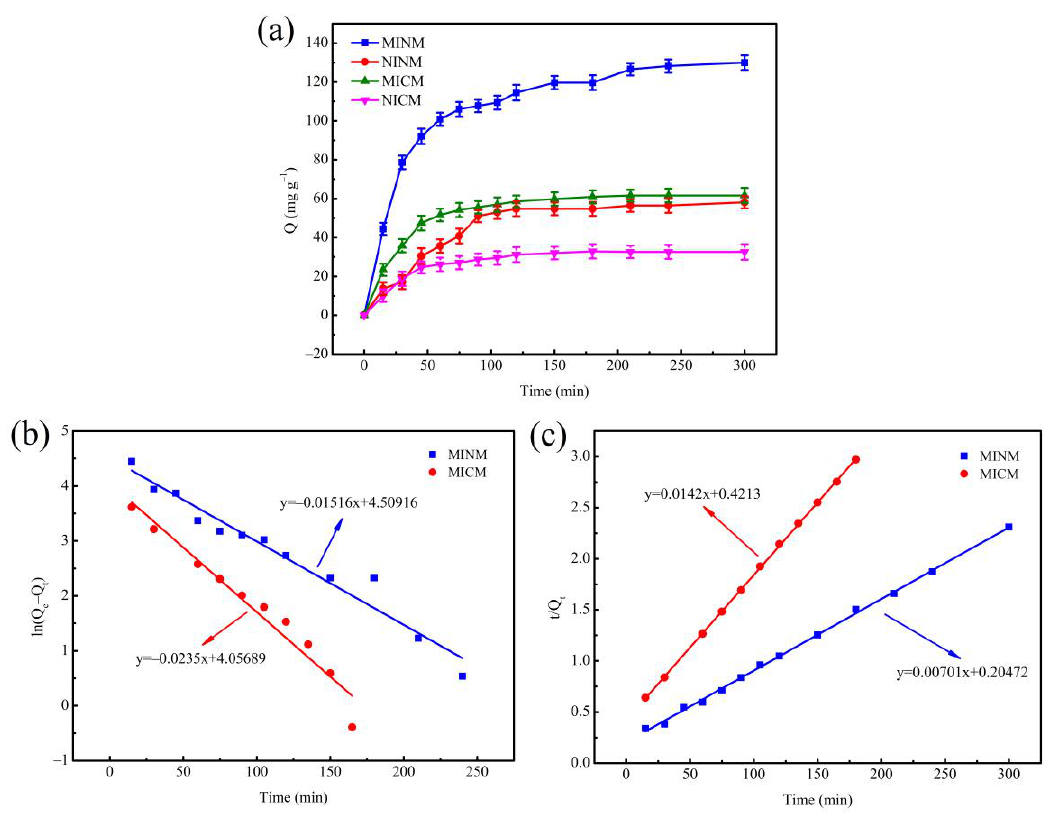
Figure 3. ( a ) The adsorption kinetics of MINM, NINM, MICM, and NICM; ( b ) the pseudo-first-order kinetic model of MINM and MICM; ( c ) the pseudo-second-order kinetic model of MINM and MICM. Table 1. Kinetic data of pseudo-first-order kinetic model and pseudo-second-order kinetic model.